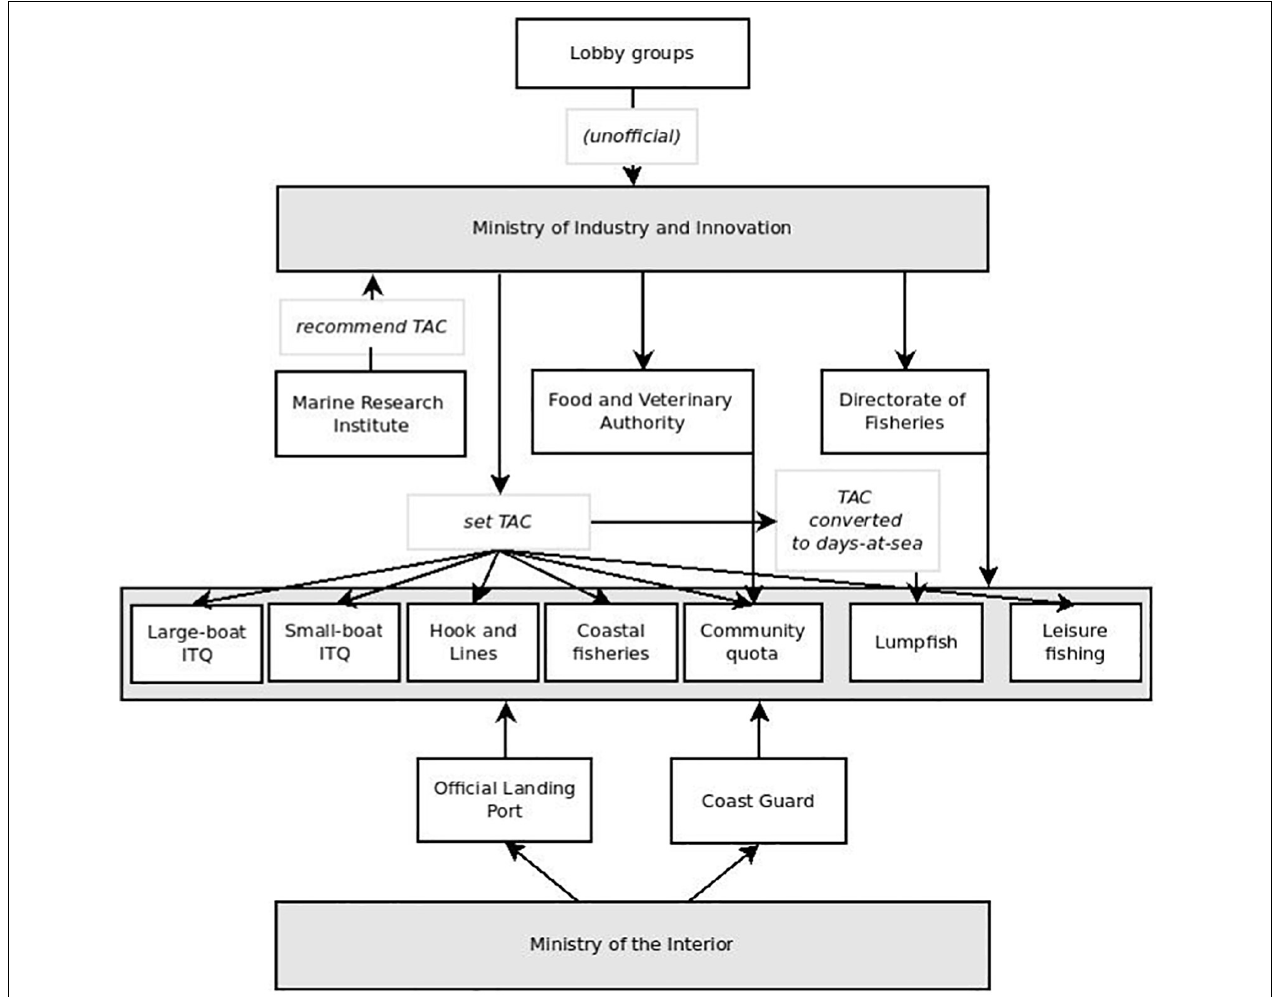
FIGURE 6 | Overview of the Icelandic fisheries system adapted from Chambers and Carothers